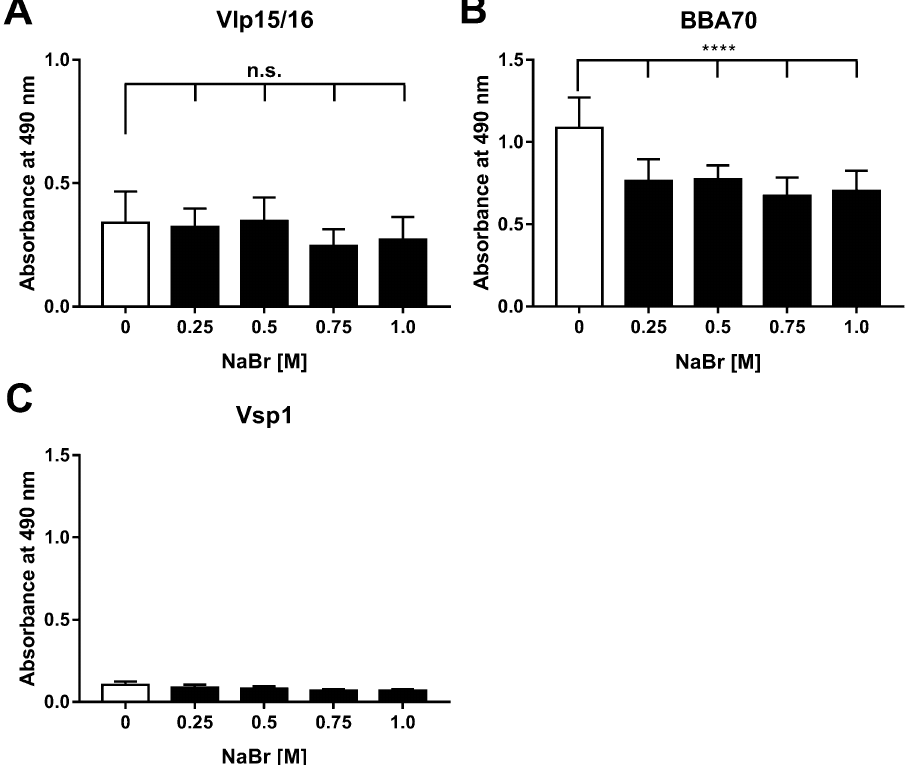
Figure 2. Influence of plasminogen binding by ionic strength. To determine influence of ionic strength on the plasminogen binding, Vlp15/16, BBA70 (positive control), and Vsp1 (negative control) (5 µg/ml each) were immobilized and incubated with plasminogen in the presence of increasing concentrations of NaBr. Bound plasminogen was detected using a polyclonal antibody (1:1000). Data represent means and standard deviation of at least three independent experiments, each conducted in triplicate. ****p ≤ 0.0001, one-way ANOVA with post-hoc Bonferroni multiple comparison test (confidence interval = 95%). n.s., no statistical